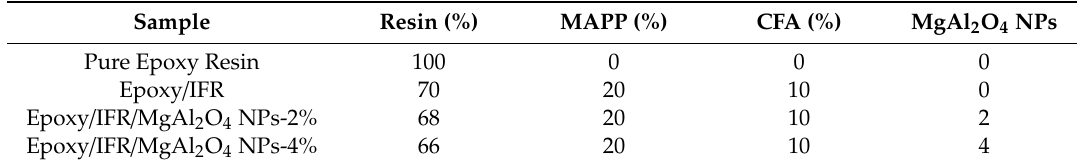
Table 1. Composition of the intumescent flame retardation